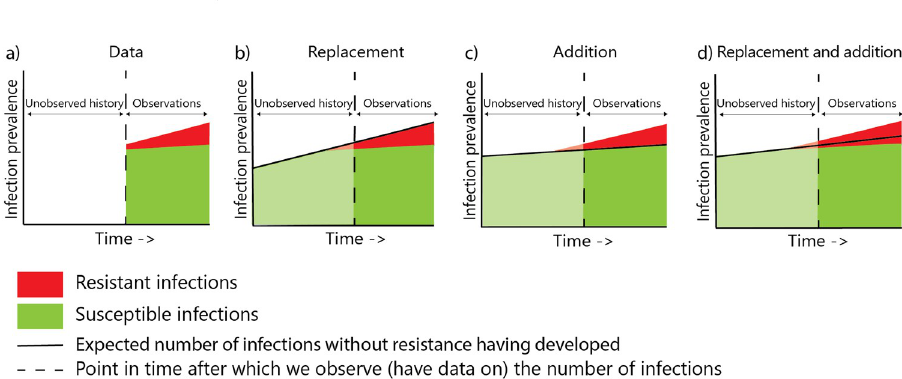
Fig 1. Three scenarios explained by addition to and replacement of susceptible infections. The observed prevalence of susceptible and resistant infections is depicted in panel a. In panel b, c and d, three potential scenarios for the prevalence in the unobserved period are depicted. Each scenario suggests a different interpretation regarding addition or